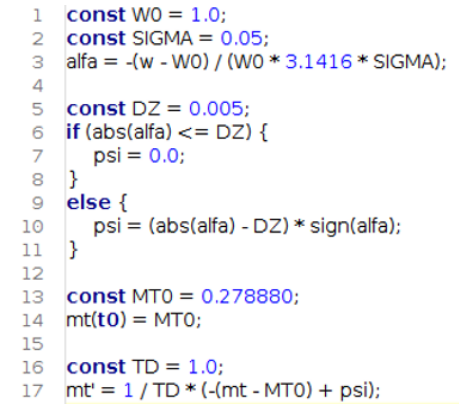
Fig. 3. Textual model of the turbine speed controller .